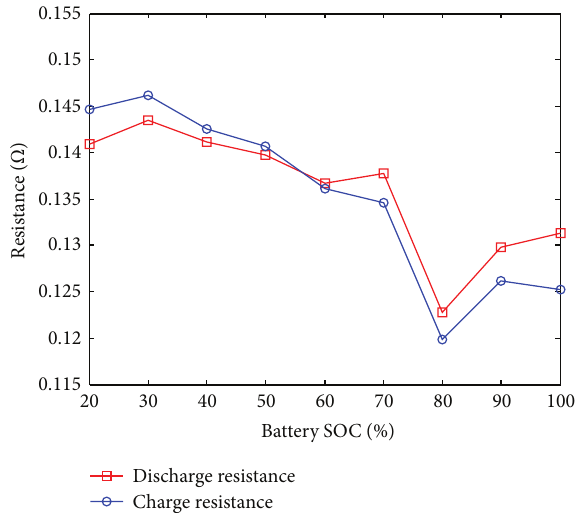
Figure 29: Charging/discharging internal resistances of the battery pack.